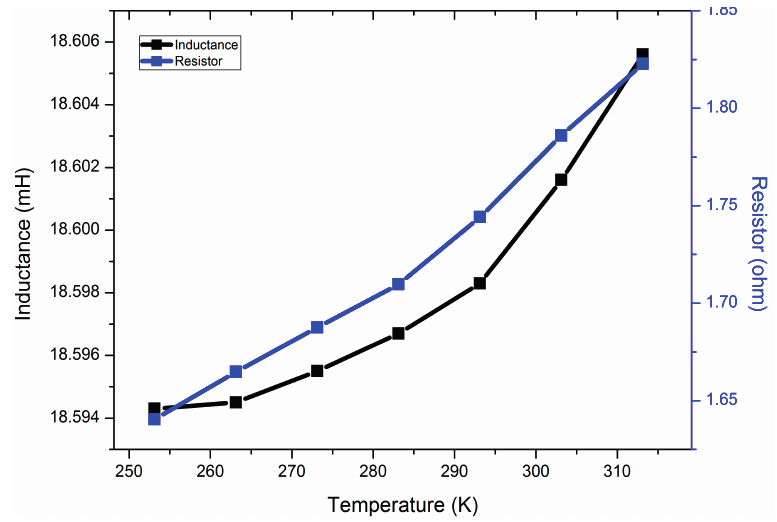
Figure 7. The inductance and resistance of Helmholtz coils varied with temperature. The temperature range is from 253 K to 313 K.